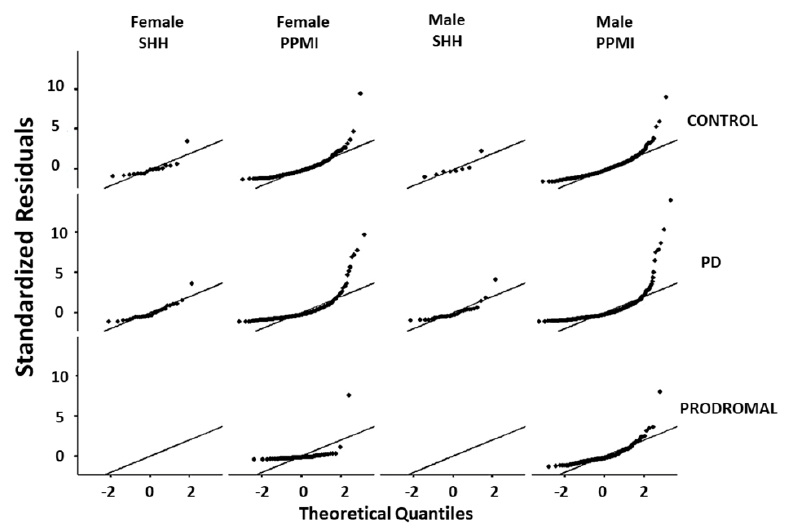
Figure 3. Graphical representation of the standardized residuals vs. theoretical quantiles of blood NfL values in control, PD, or prodromal cases from male or female participants in the SHH and PPMI cohorts. SHH, Shuang Ho Hospital; PPMI, Parkinson’s Progression Markers Initiative.